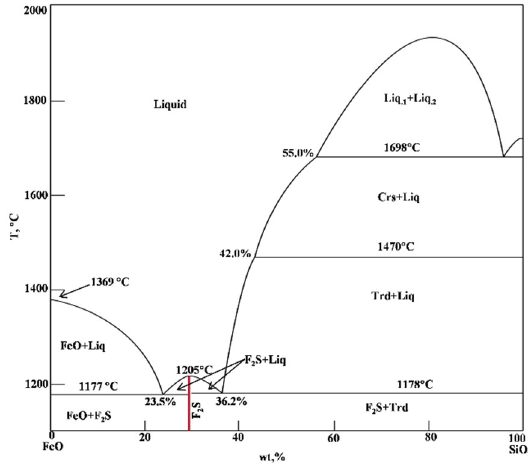
Figure 13. The binary phase diagram of FeO-SiO 2 .